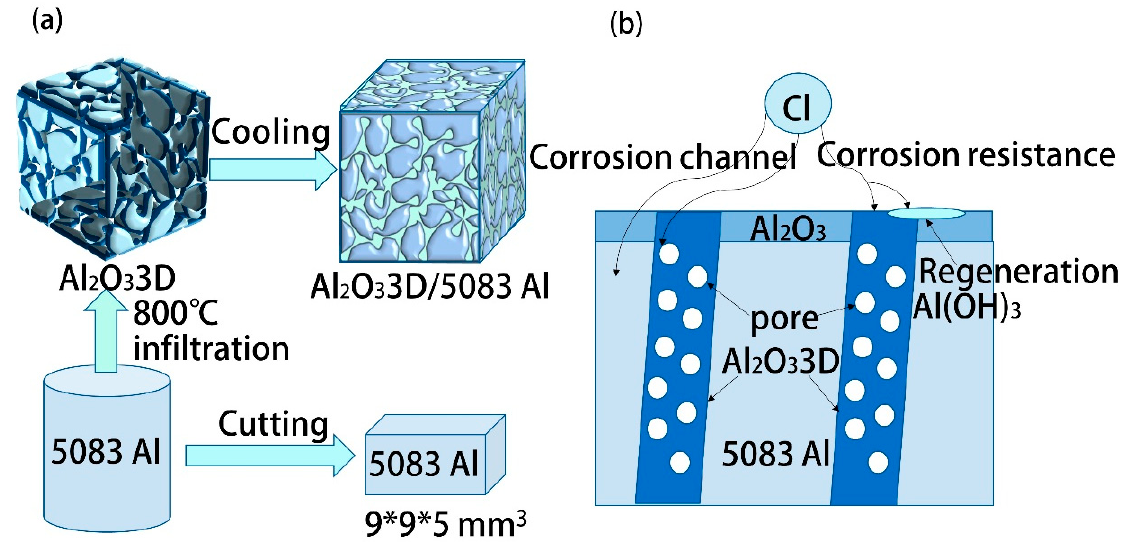
Figure 1. Preliminary preparation and corrosion direction: ( a ) preparation flow chart; ( b ) corrosion direction.